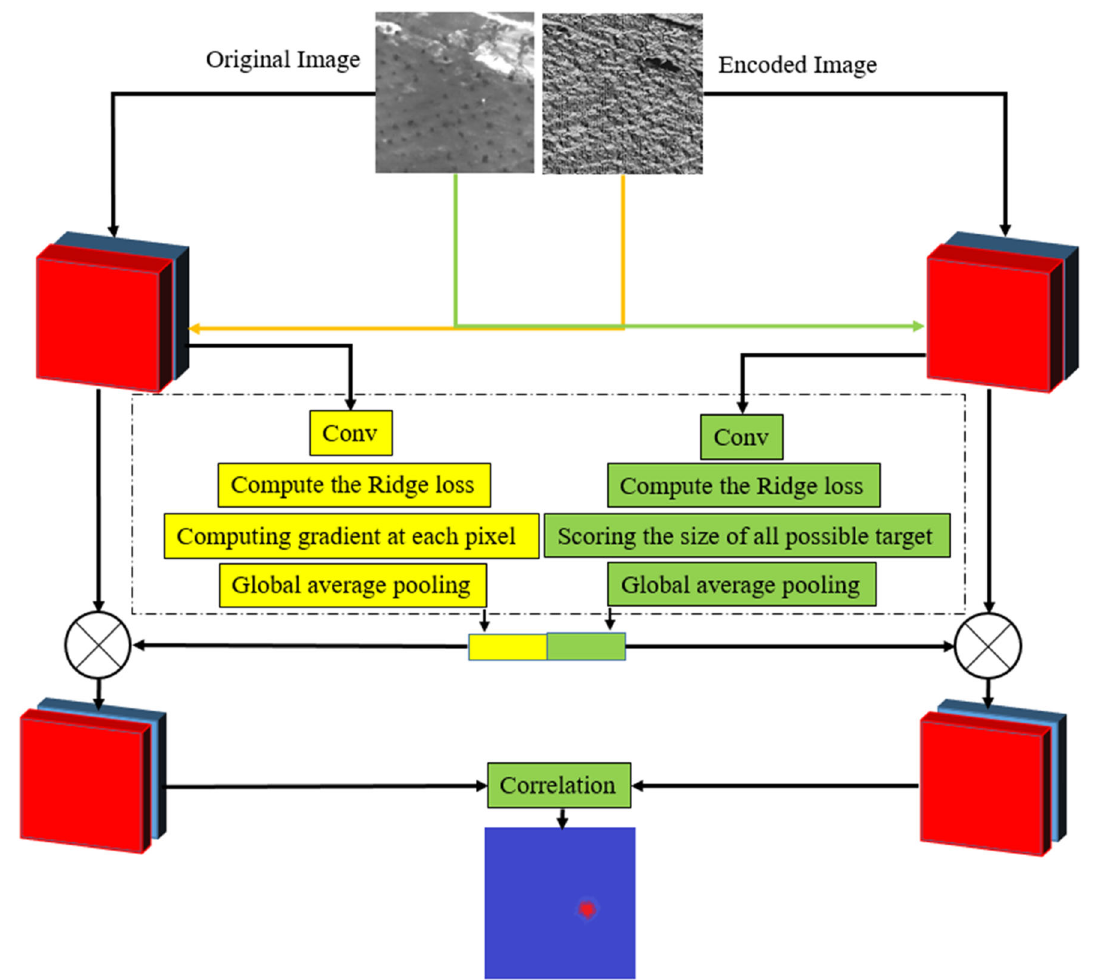
Fig. 4 Schematic of our framework for target detection and tracking in infrared images